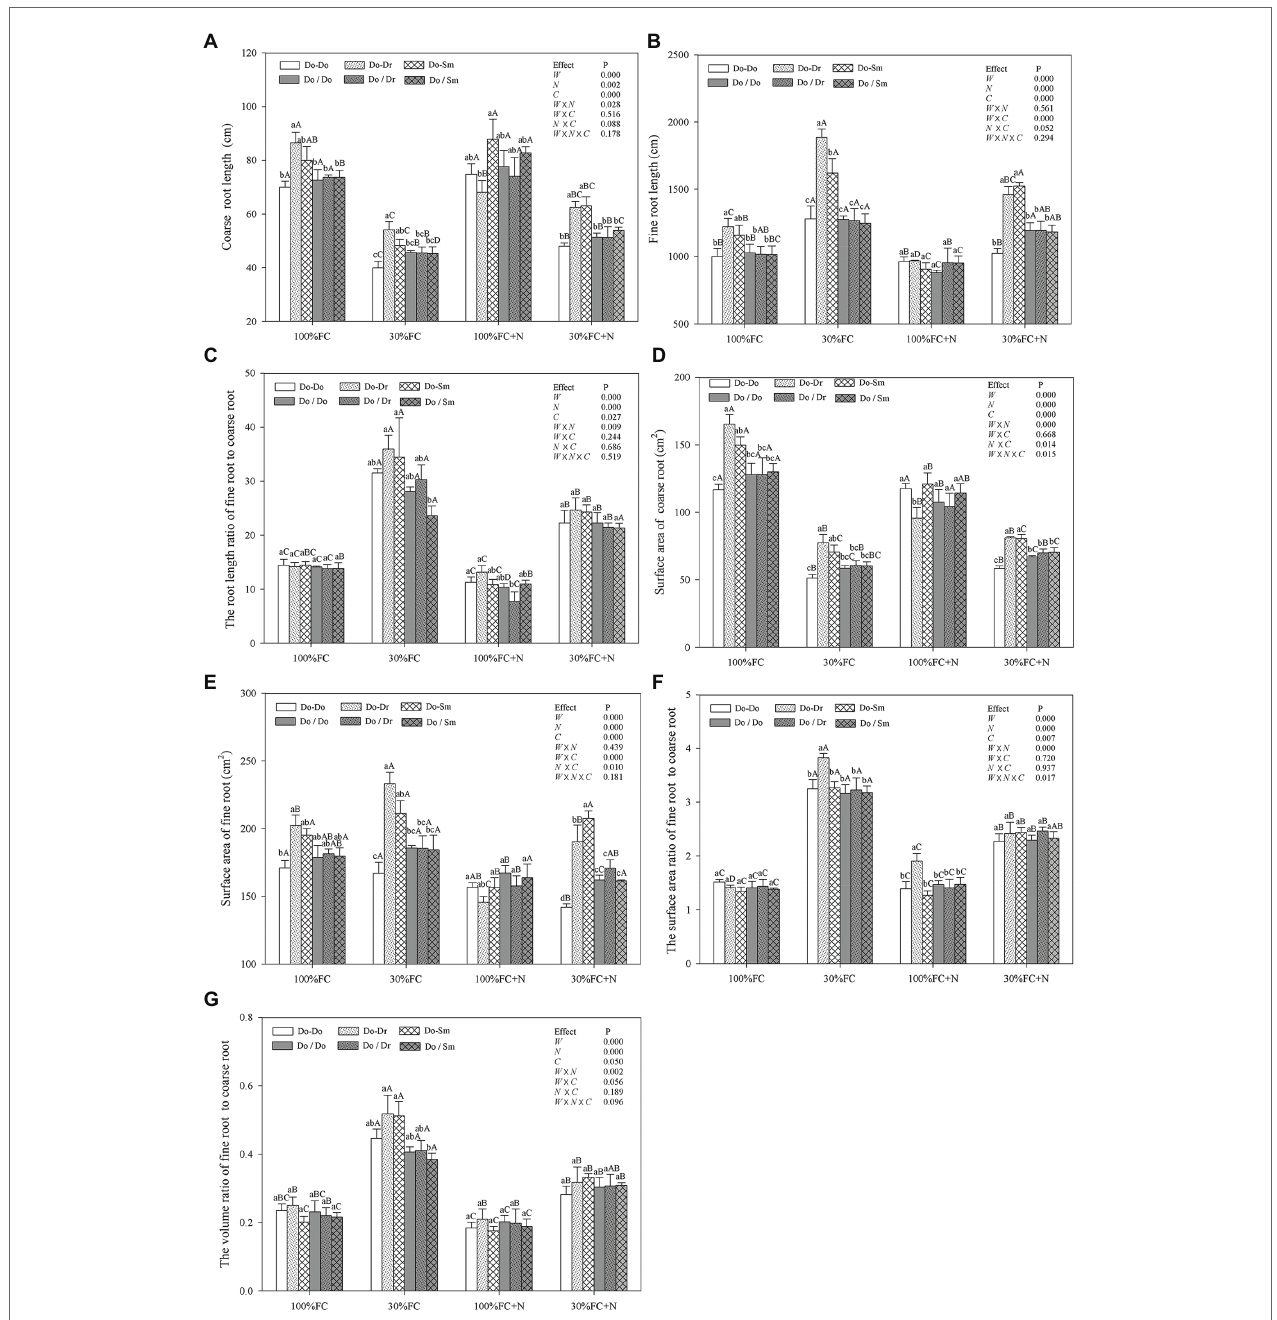
FIGURE 3 | Effects of water, N fertilization levels, and species competition models on coarse root length (A) , fine root length (B) , the root length ratio of fine root to coarse root (C) , coarse root surface area (D) , fine root surface area (E) , the root surface area ratio of fine root to coarse root (F) , and the root volume ratio of fine root to coarse root (G) of D. odorifera . Different lowercases in each graph indicate significant difference among different competitive models (competition between D. odorifera and various N-fixing niche neighbors) under the same water and N application according to Duncan’s tests ( p < 0.05). Different uppercases in each graph indicate significant difference among different water and N fertilization application in the same competitive models according to Duncan’s tests. For abbreviations explanation of treatments (species competition models, water, and N fertilization), data description, and statistics are the same as shown in Figure 1